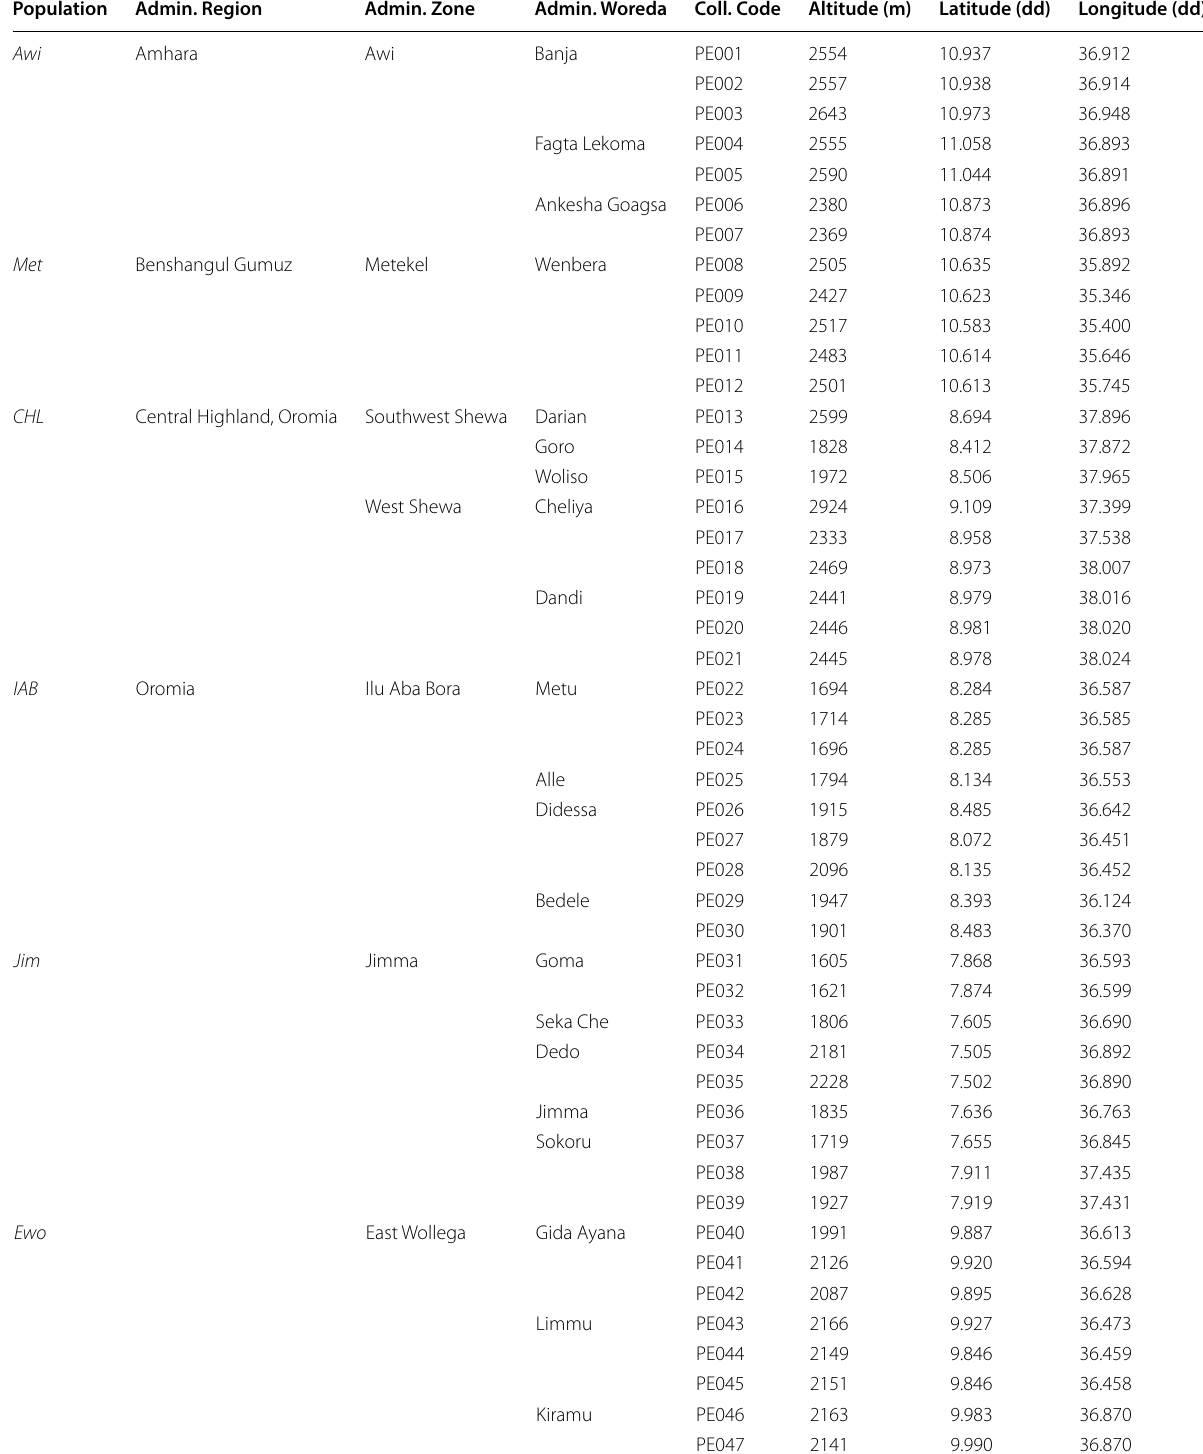
Table 1 List of P. edulis populations and the administrative regions, zones and woredas of collection used in the present study, along with their altitude, latitude and longitude Population Admin. Region Awi Amhara